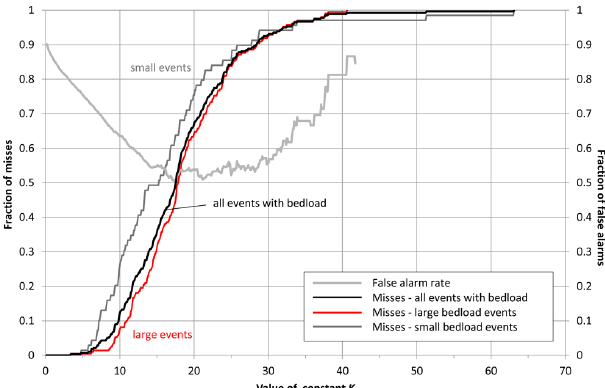
Fig. 8. Fraction of misses (rainfall events leading to bedload trans- port that lie below the threshold line divided by the total number of events with bedload) and fraction of false alarms for the Erlenbach stream as a function of the prefactor K of the rainfall intensity– duration threshold line (Eq. 1). Note that the false alarm rate is discontinued for values of K > 42 because there are practically no more rainfall events with bedload transport above the threshold